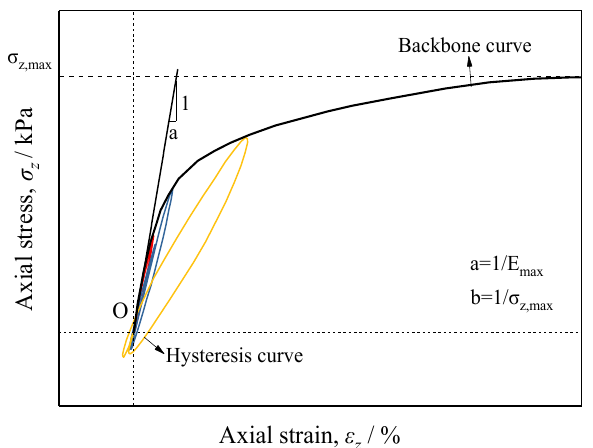
Figure 12. Schematic diagram of stress–strain backbone curve.